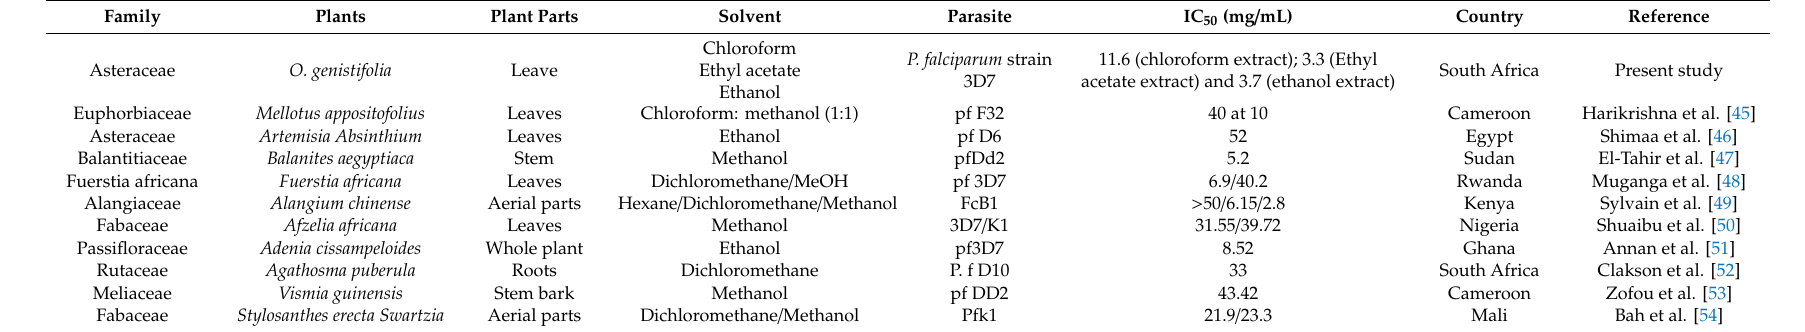
Table 3. Some examples of reported studies on antimalarial activities of plant extracts from di ff erent regions in